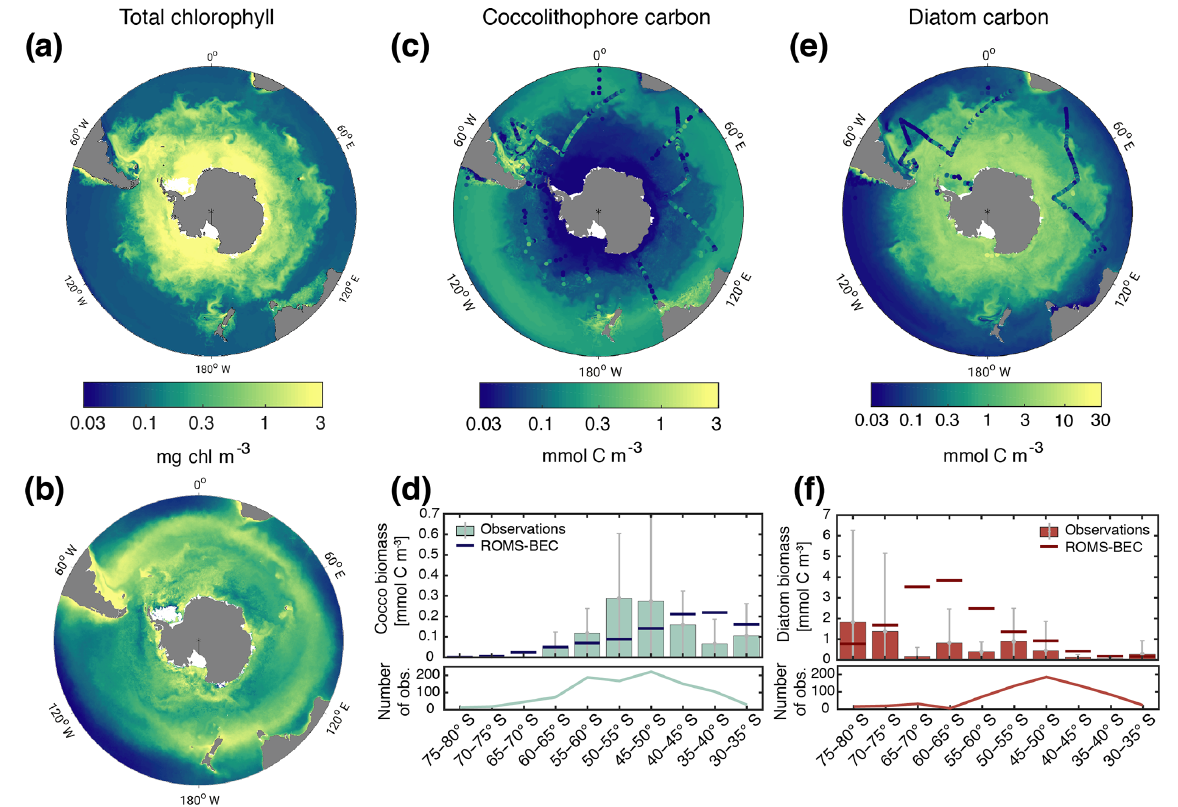
Figure 1. Biomass distributions for December–March (DJFM). Total surface chlorophyll (mgChlm − 3 ) in (a) ROMS–BEC and (b) MODIS Aqua climatology (NASA-OBPG, 2014a) using the chlorophyll algorithm by Johnson et al. (2013). Mean top 50m (c) coccolithophore and (e) diatom carbon biomass (mmolCm − 3 ) in ROMS–BEC. Coccolithophore and diatom biomass observations from the top 50m are indicated by colored dots in (c, e) , respectively. (d, f) Mean top 50m zonally averaged (d) coccolithophore and (f) diatom carbon biomass (mmolCm − 3 ) binned into 5 ◦ latitudinal intervals for ROMS–BEC (line) and observations (bars). The grey bars denote the standard deviation of the observations. The lower panels show the number of observations used to obtain the bars in the respective upper panels. Note that (a) – (b) are on the same scale, while the scales in panels (c) – (f) are different. For more details on the biomass validation, see Table A1 and the